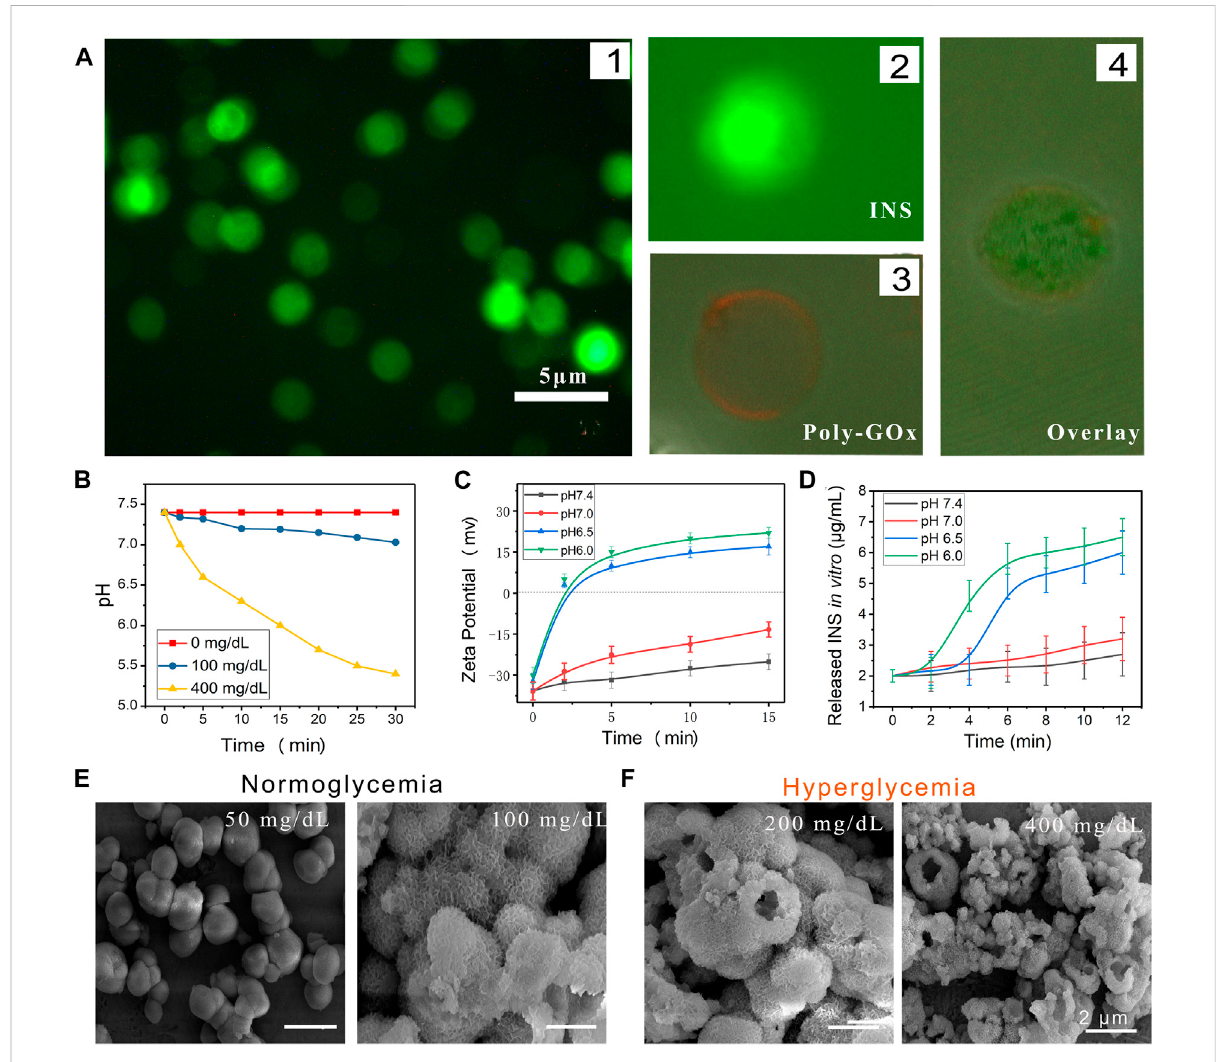
FIGURE 4 The mechanism of glucose-activated INS release behavior of mmLbL-INS microcapsules. (A) Fluorescence image of mmLbL-INS microcapsules. FITC-labeled INS (green) and rhodamine B (red)-modi fi ed biotin-GOx were used to fabricate mmLbL-INS microcapsules. (B) Relevant pH changes observed in different incubation solutions with mmLbL-INS microcapsules. (C) Charge conversion of anionic polymers at differentpH. (D) INSreleasebehaviorofmmLbL-INSmicrocapsulesindifferentpHsolutions. (E,F) SEMofmmLbL-INSmicrocapsulesimmersed in different glucose